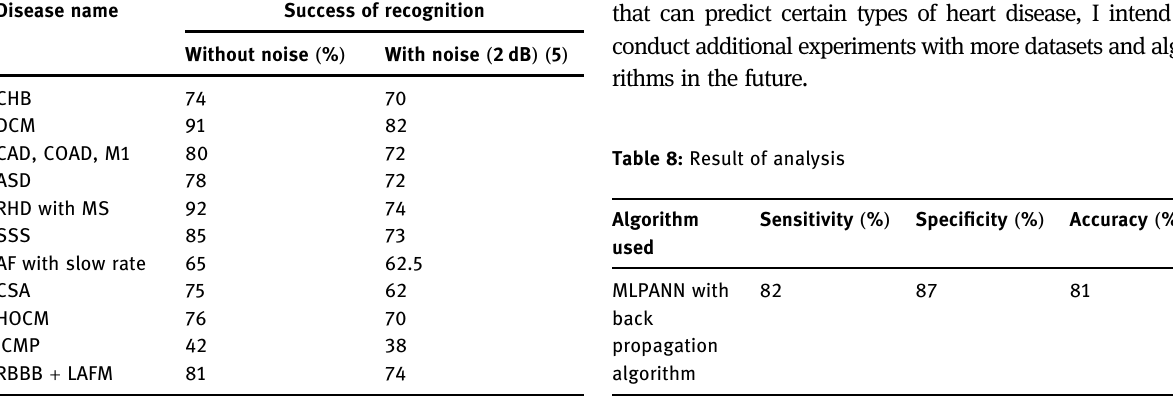
Table 7: Summary of recognition rate for di ff erent cardiovascular diseases Disease name